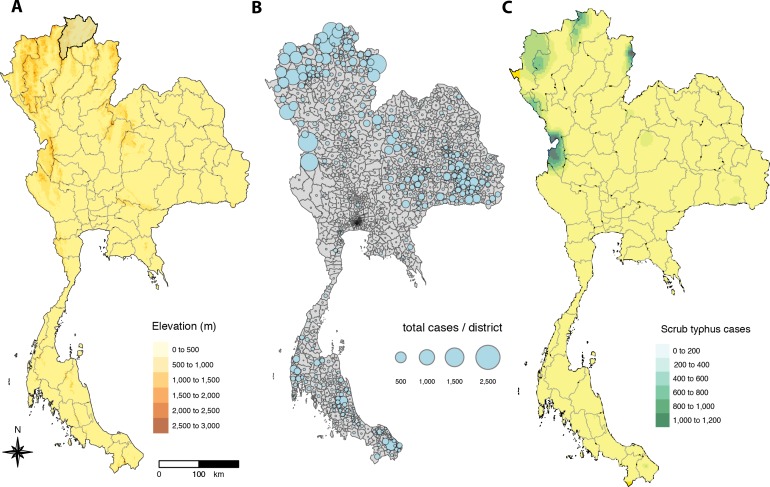
Map of Thailand depicting: (A) the geography with elevation, provincial boundaries and location of Chiangrai province; (B) total scrub typhus cases from 2003–2018 per district; and (C) interpolation of scrub typhus cases at sub-district level by kriging using semi-variogram based on the centroids of geographical coordinates of each sub-district (for clarity, only provincial boundaries are shown) [created using tmap and tmaptools in R software–R Core Team 2018 [38–40]].